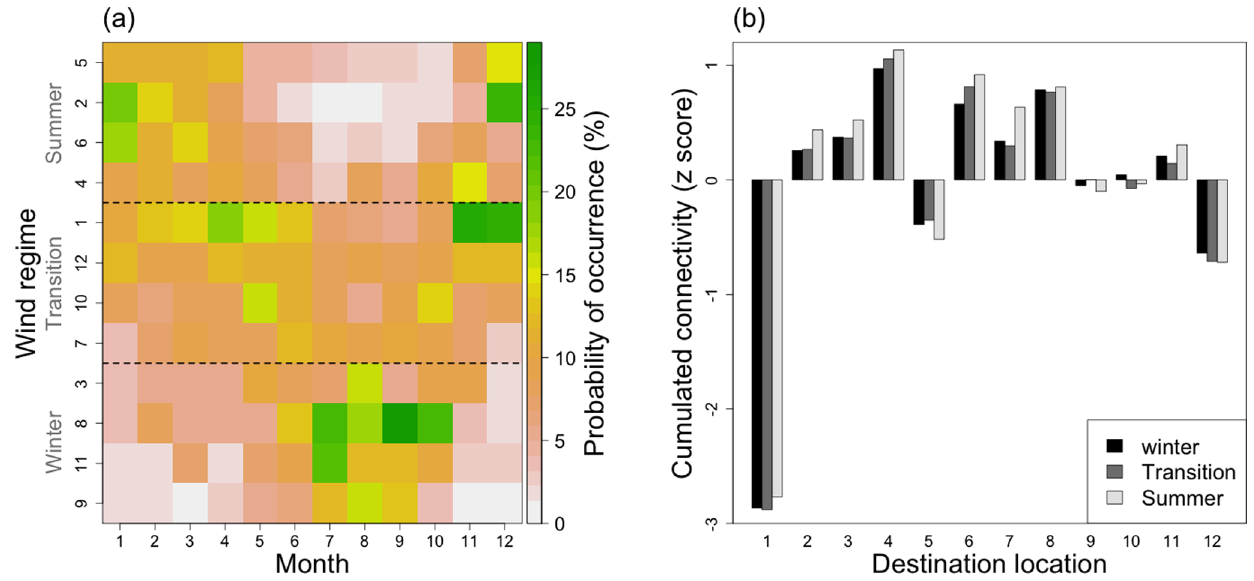
Figure 10. Seasonal pattern of connectivity. (a) Monthly probability of occurrence (in %) of each wind regime and (b) cumulated realistic connectivity, by season. The data used for realistic connectivity are the sum of the reared and natural scenarios. The connectivity is standardized using the standard score z.